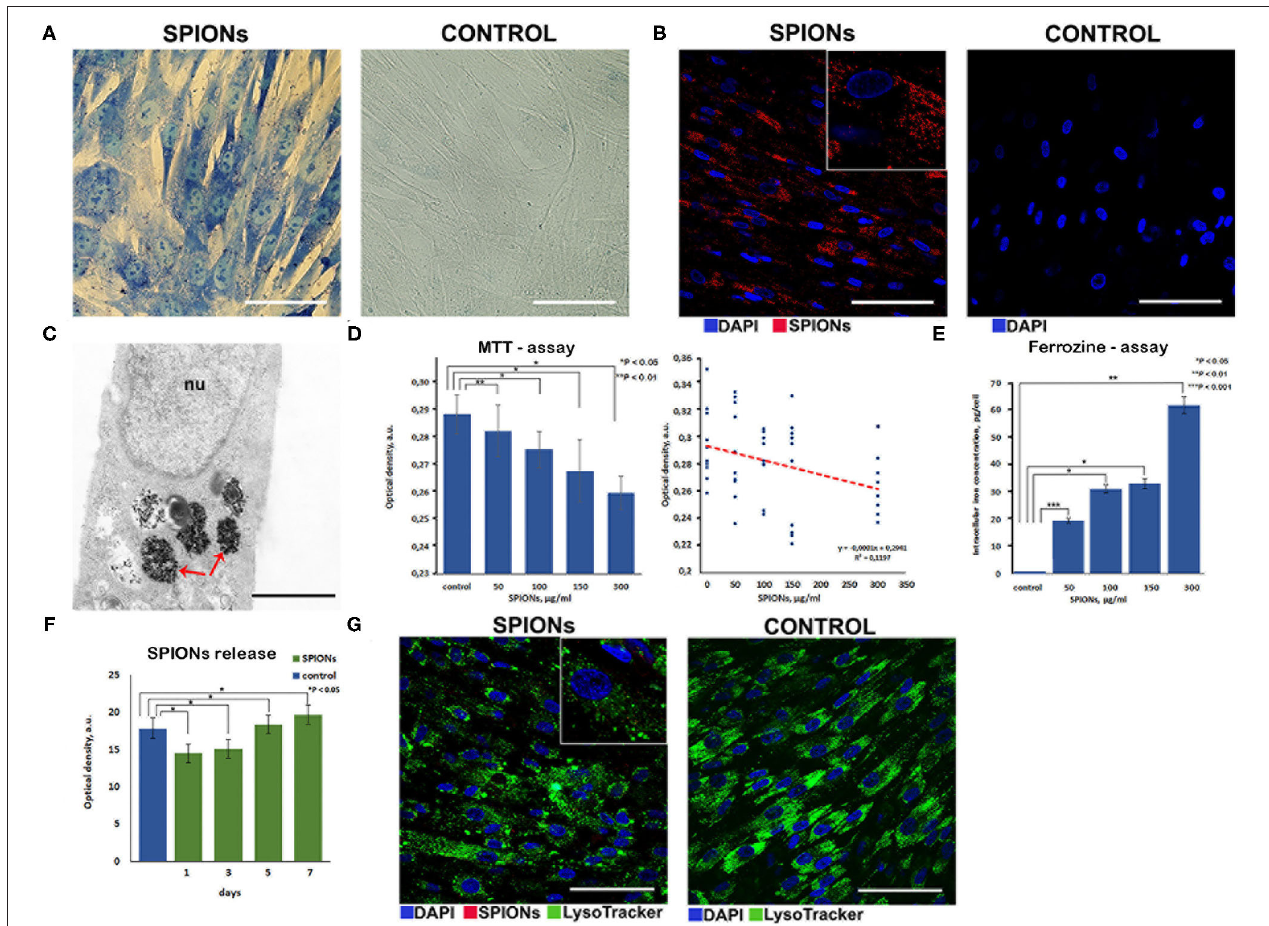
FIGURE 4 | Assessment of nanoparticles internalization by mesenchymal stem cells. (A) Prussian blue staining of the SPION-loaded MCSs. Scale bars, 50 µ m. (B) Confocal microscopy images of MSCs co-incubated with SPIONs (150 µ g/ml) for 24h and control (non-treated cells), respectively. Nuclei were stained with DAPI (blue). SPIONs were detected by reflected laser scanning (red). Scale bars, 100 µ m. (C) TEM image of the SPIONs. Red arrows point to secondary endosomes filled with heterogeneous material, including electron-dense nanoparticles. Scale bar is 400nm. (D) The influence of the different concentrations of SPIONs on the viability of cells and a linear regression analysis of MTT data, respectively. Levels of significance between all experimental and control groups are shown as * P < 0.05; ** P < 0.01. (E) Correlation between an increase in the concentration of SPIONs and a corresponding increase in the concentration of iron in MSCs. Levels of significance between all experimental and control groups are shown as * P < 0.05; ** P < 0.01; *** P < 0.001. (F) Spectrophotometric analysis of the nanoparticles release into the medium from the SPION-loaded MSCs. Data are presented as M SD from three independent experiments. (G) Analysis of the co-localization of SPIONs and ± endolysosomes. Nuclei were stained with DAPI (blue). Lysosomes were stained with LysoTracker dye (green). SPIONs were detected by reflected laser scanning (red). Scale bars, 100 µ